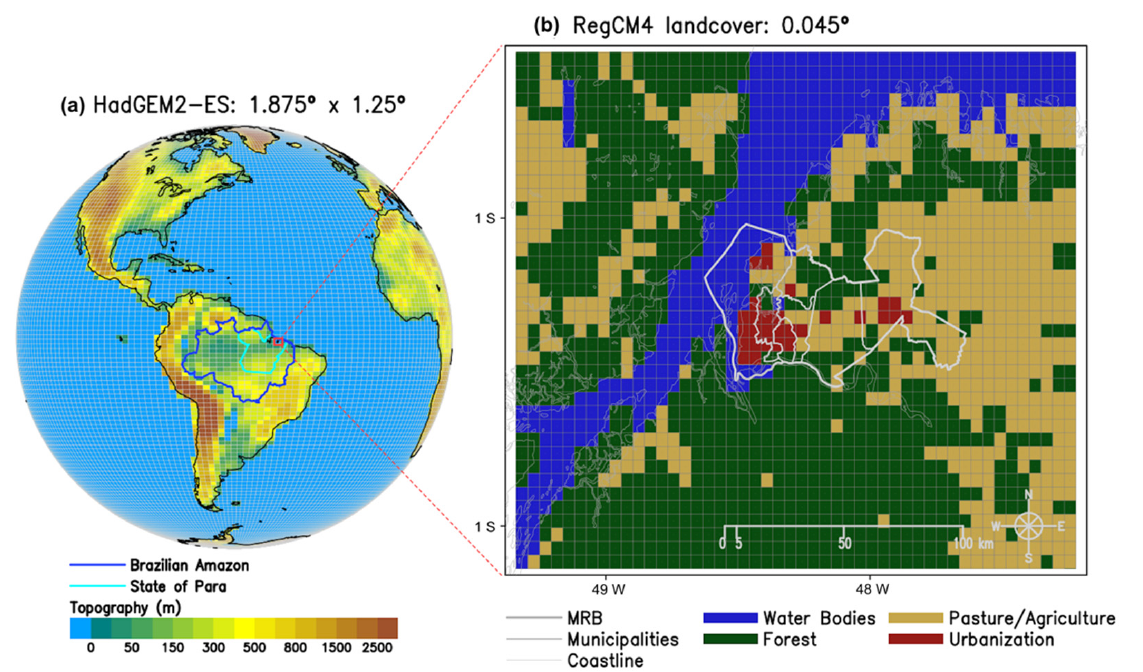
Figure 2. ( a ) HadGEM2-ES global model (topography); ( b ) RegCM4 domain over MRB with the landcover updated to represent the metropolitan region of the study area.